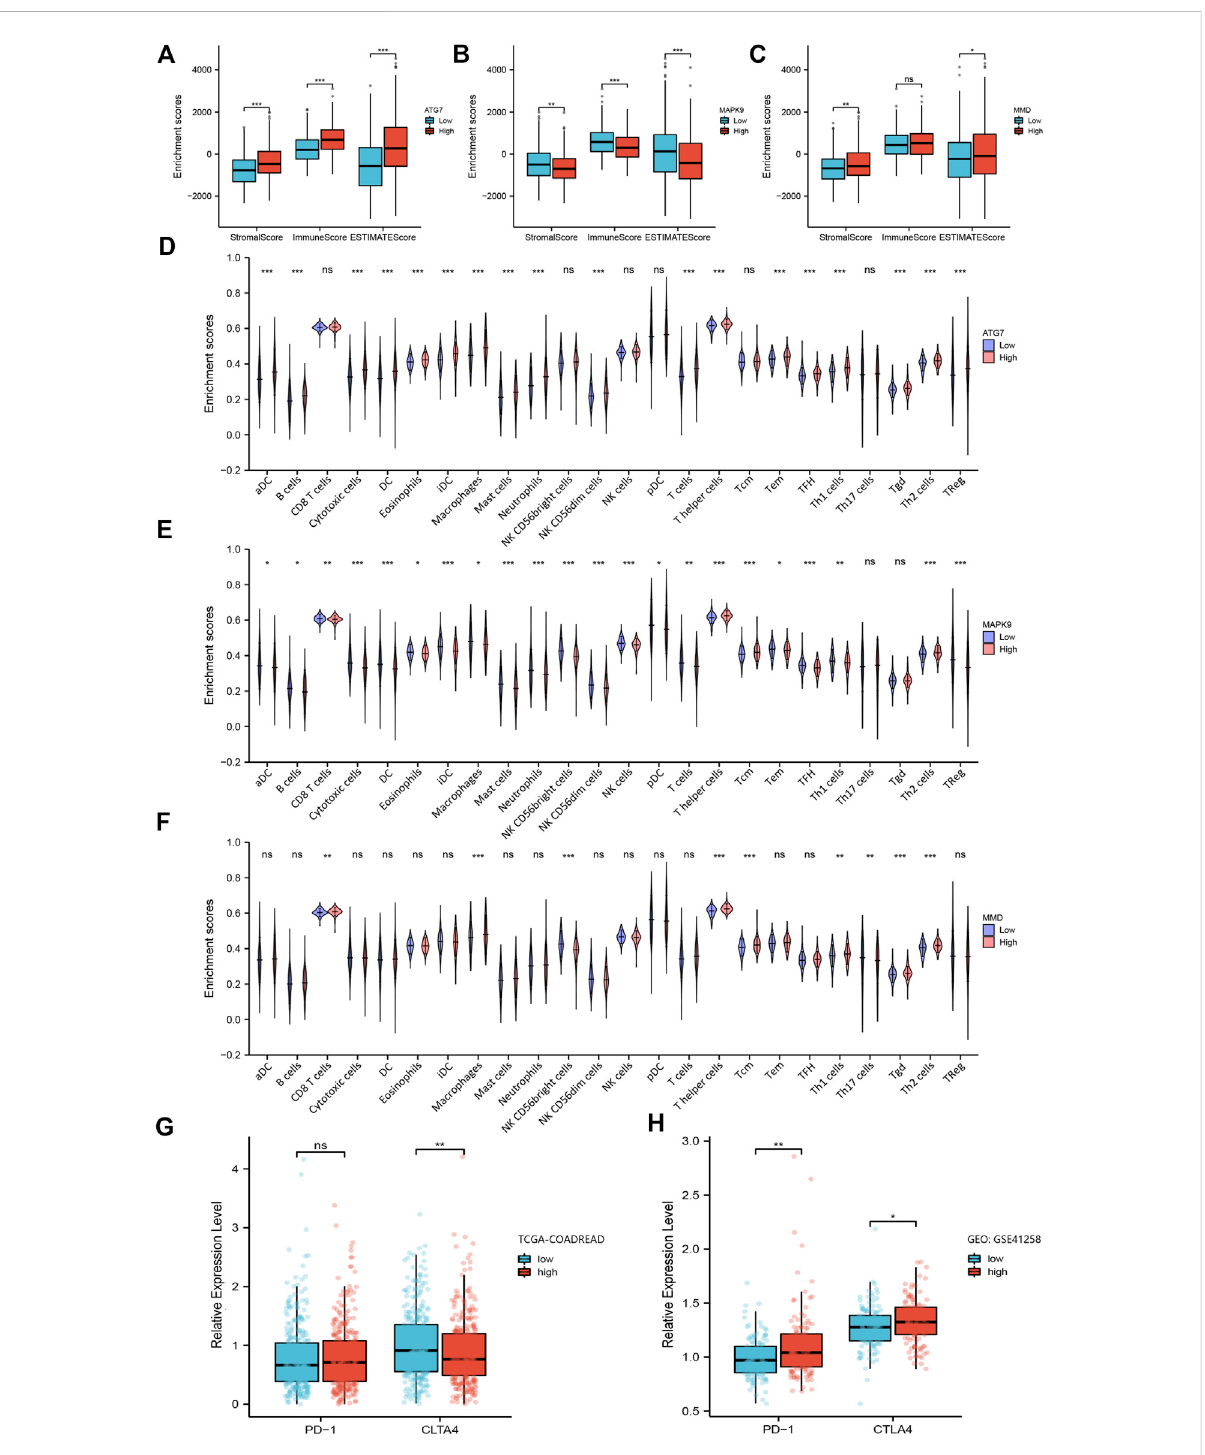
FIGURE 5 Analysis of the relationship between ferroptosis-related prognosis genes with immune microenvironment. (A – C) Box plots of ferroptosis- related genes ATG7,MAPK9 and MMD obtained bythe ESTIMATE algorithm, showingtheir stromalscore,immunescore and ESTIMATE score. (D – F) Violin plots of ferroptosis-related genes ATG7, MAPK9 and MMD obtained by ssGSEA algorithm, showing the distribution of various immune cells between low group and high group. (G – H) The expression level of PD-1 and CTLA4 in the low-risk group and high-risk group in TCGA- COADREAD cohort and GEO: GSE41258, respectively. *, p < 0.05; **, p < 0.01; ***, p <